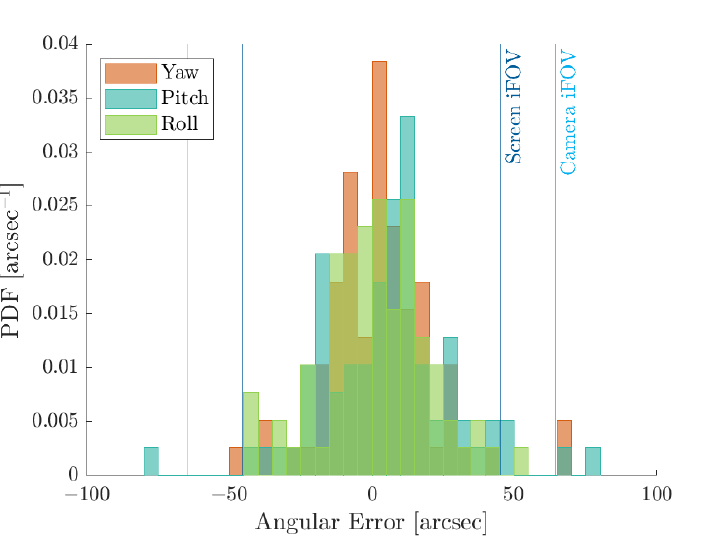
Figure 19. The error in roll, pitch, and yaw between the estimated and true spacecraft-fixed refer- ence